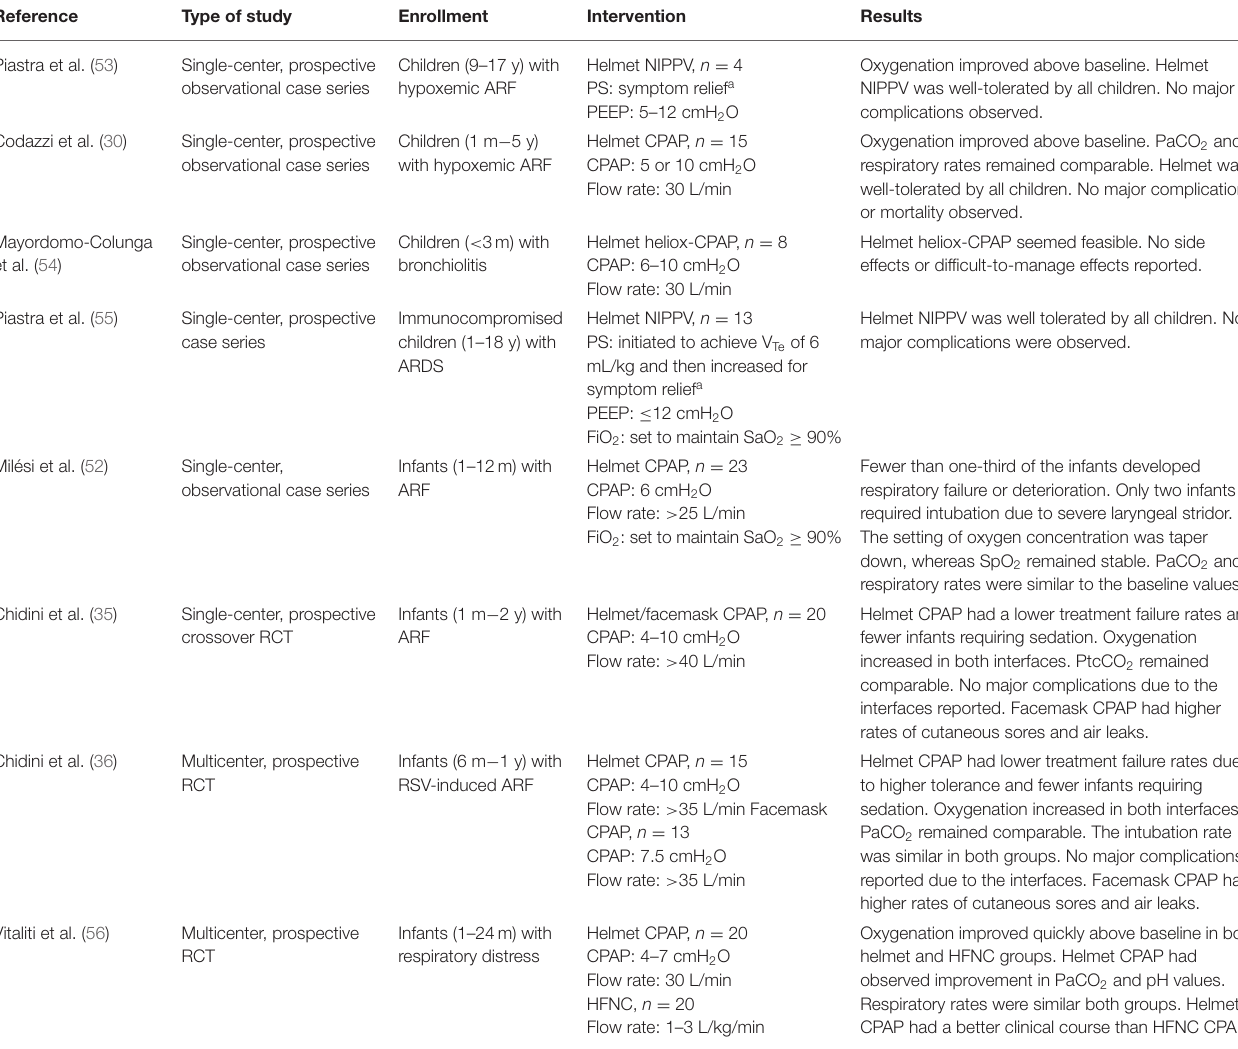
TABLE 1 | Clinical trials of pediatric helmet CPAP and